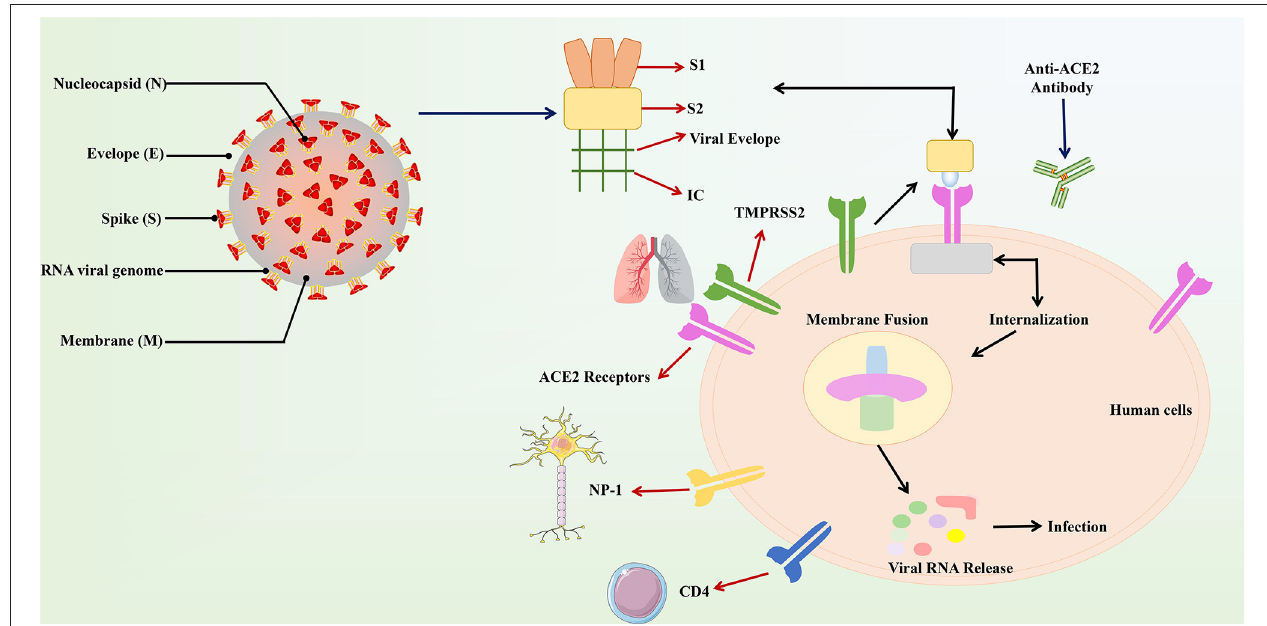
FIGURE 1 | The structure and combination of COVID-19 virus and ACE2. The COVID-19 virus was described in the above figure. In the structure of the virus, the S protein plays a major role in the binding of the virus to the host recipient cell. The S protein is composed of the S1 receptor binding subunit and the S2 membrane fusion subunit. Then S2 subunit is internalized on the ACE2 receptor connected to human host cells and produces the membrane fusion among the viral subunit and the ACE2 receptors. This results in the release of viral RNA into the host cell and causes respiratory